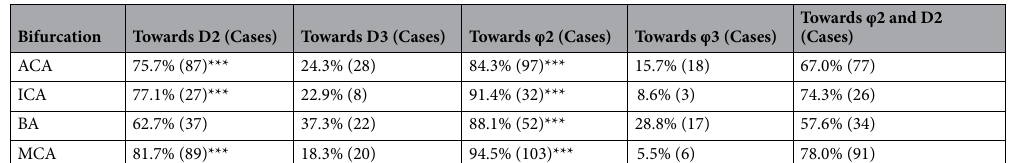
Table 3. Aneurysms deviation. ACA anterior cerebral artery, ICA internal carotid artery, BA basilar artery, MCA middle cerebral artery. *** P < 0.001 between D2 and D3 and between φ2 and φ3. D2 and D3 indicate smaller and larger daughter branch, respectively. φ2 and φ3 represent smaller and larger lateral angle, respectively.